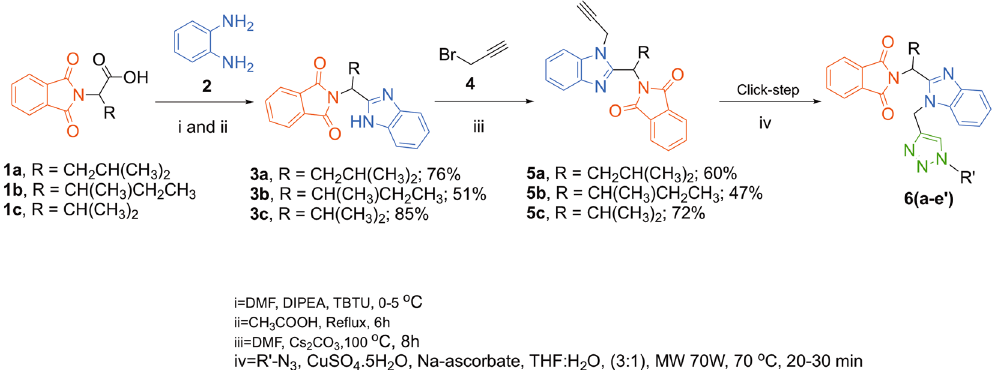
Figure 1. Synthesis of Pht analogues 6a – e ′